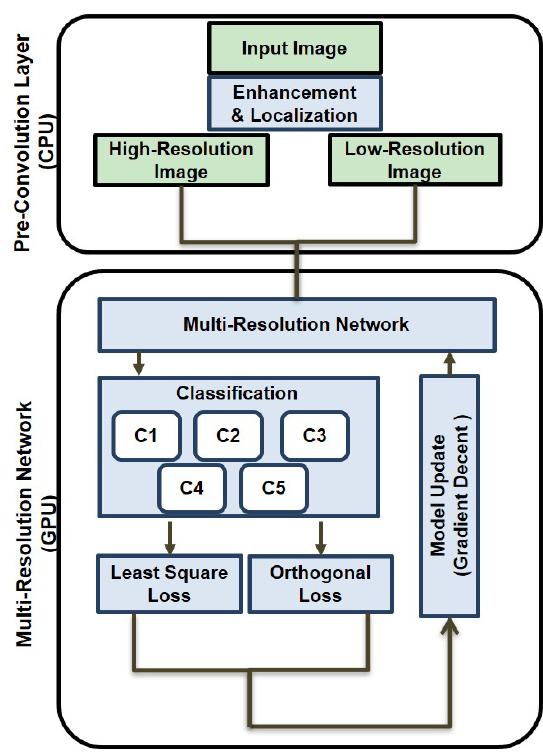
Figure 9. Dual procedure of the proposed method using both CPU and